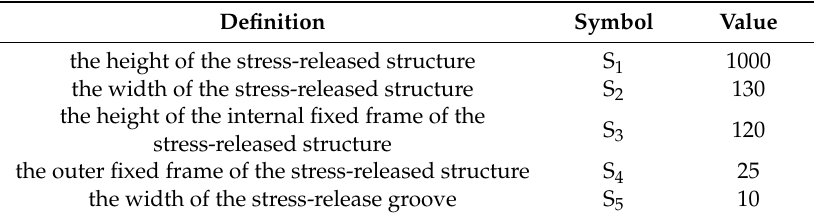
Table 1. Structural parameters of the stress-released structure (unit: μ m).